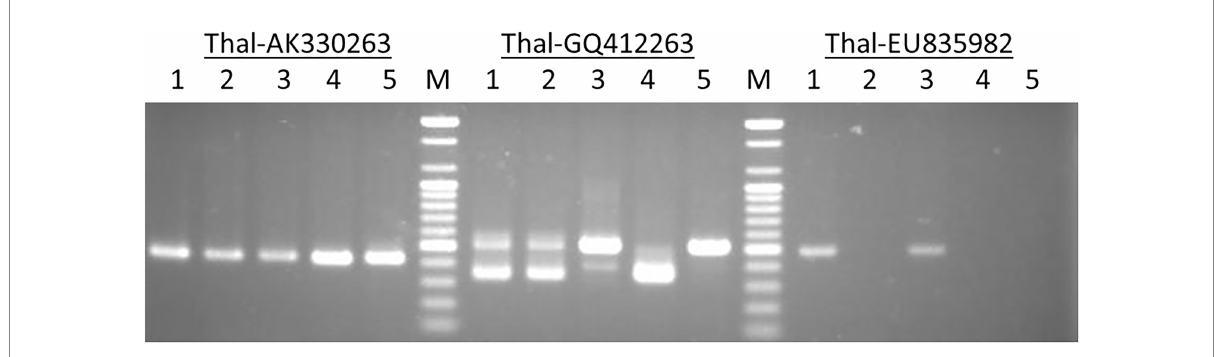
FIGURE 1 An example of a site-specific PCR for Thalos (Thal-GQ169689) that was inserted in the 11th intron of the plastid glutamine synthetase 2 ( GS2 ) gene in five accessions. The expected “full site,” i.e., the larger band of ~519 bp was found only in the hexaploid Chinese Spring and Norin 61 (Lanes 1 and 3). The Synthetic hexaploid wheat (Lane 2) along with the tetraploid T. turgidum (Lane 4) and the diploid Ae. tauschii (Lane 5) lacked the full insertion site and only the “empty site,” i.e., the lower band of ~367 bp was